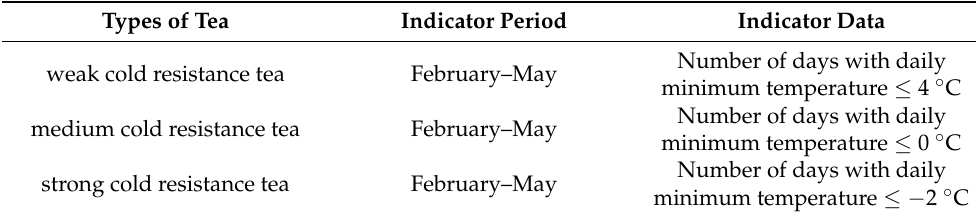
Table 4. Indicators of tea with different cold resistance in